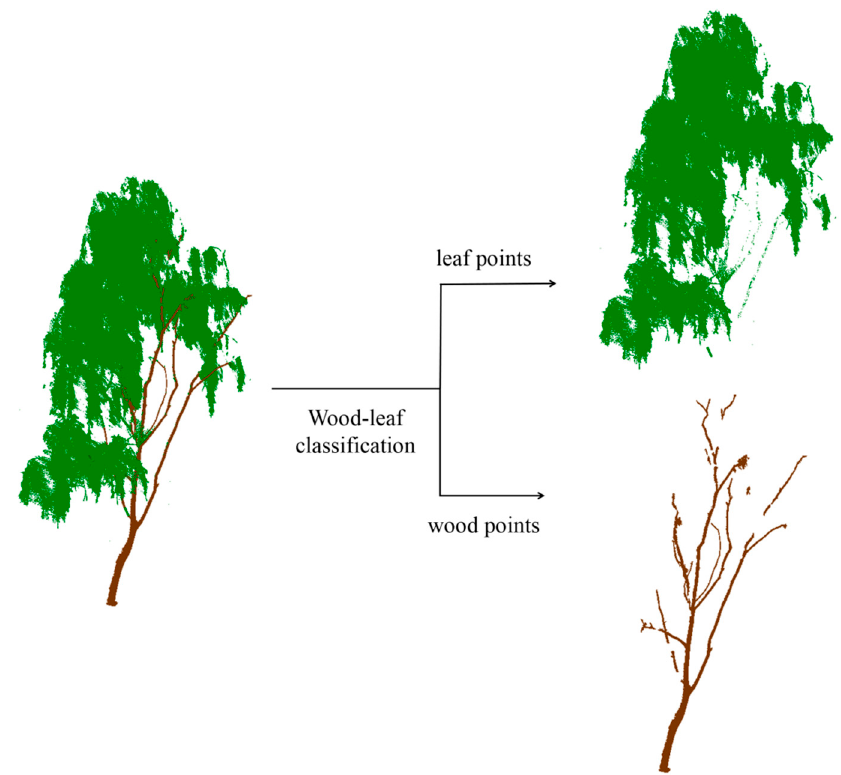
Figure 2. Demonstration of wood–leaf separation result using Tree 7. Brown: wood points; Green: leaf points.